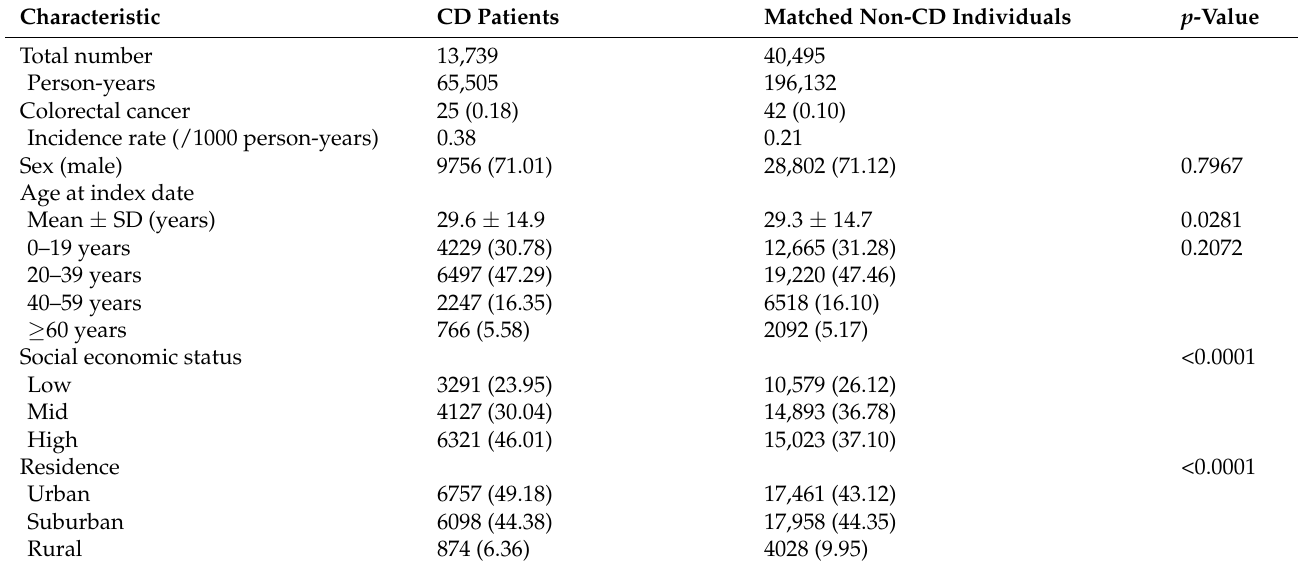
Table 1. Baseline characteristics of the study population.